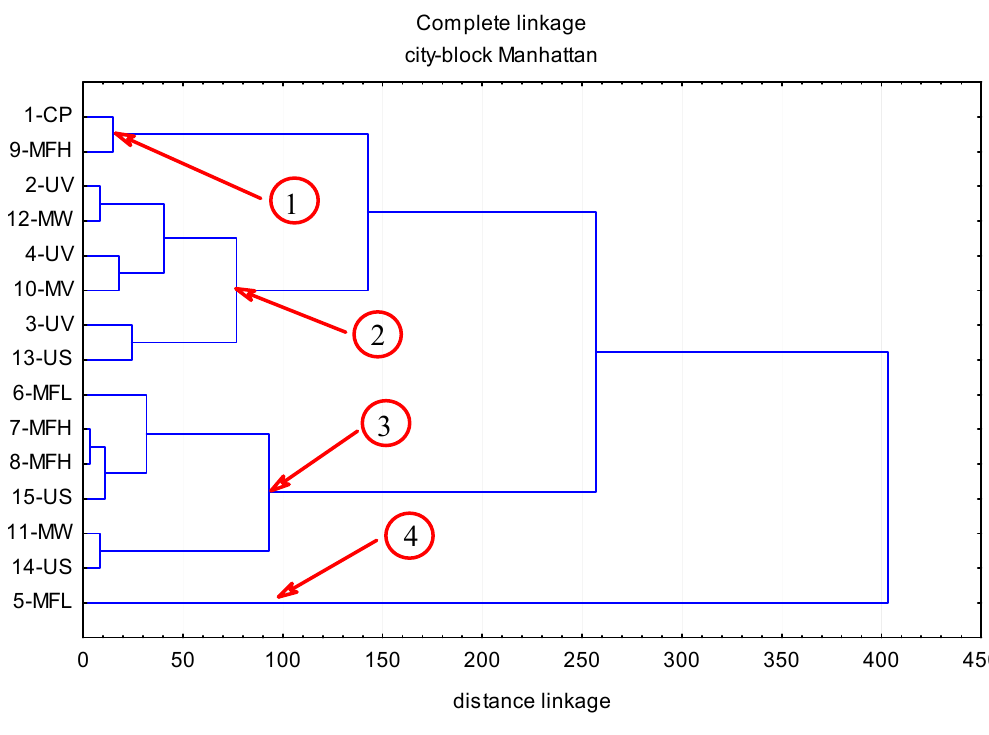
Figure 2. The influence of abiotic stress factors (UV-C electromagnetic field of the microwave field, ultrasound) on the content of chlorogenic acid in chokeberry fruits.